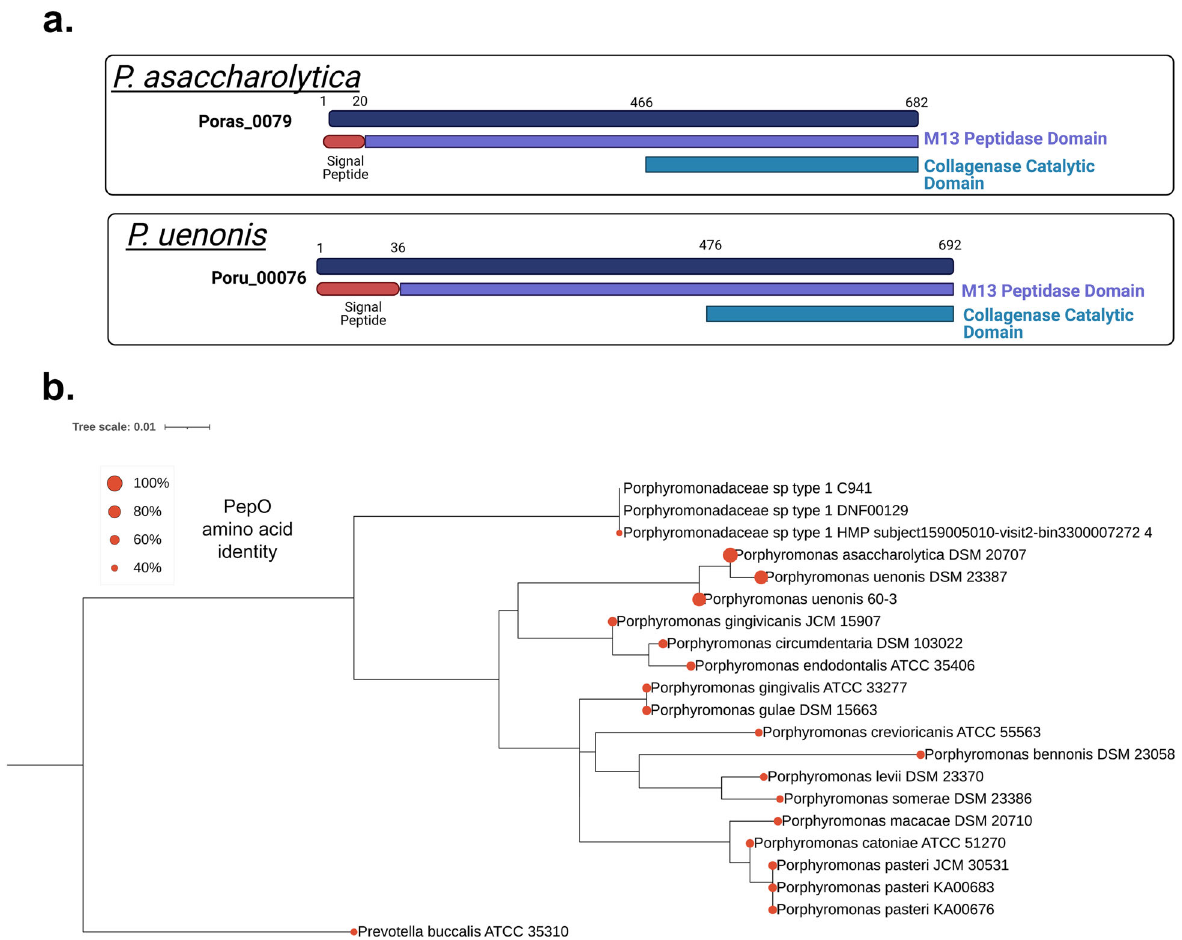
Fig. 6 Secreted PepO metallopeptidases identi fi ed in P. asaccharolytica and P. uenonis . a Domain structure of candidate host-degrading PepO metalloproteases from P. asaccharolytica and P. uenonis . Created with BioRender.com. b 16S rRNA gene phylogeny of Porphyromonas species identi fi ed in the urogenital tract presented as a Maximum Likelihood tree rooted to Prevotella buccalis (same order, different family). Red circles on each leaf indicate the percent amino acid identity of that species ’ PepO ortholog compared to P. asaccharolytica PepO (Poras_0079 = 100%). The taxon previously identi fi ed as uncultivated Porphyromonas species type 1 was found to encompass two cultured, but unsequenced isolates (DNF00129 and C941, >99% 16S rRNA gene identity over 1120 nt). We identi fi ed a metagenome-assembled genome (MAG) in IMG/MER that encoded a 958 bp 16S rRNA gene fragment >99.5% identical to those from the cultured isolates DNF00129 and C941. Since this MAG represents the only genome sequence available for this species, we used it in our PepO queries, identifying an ortholog 42% identical to P. asaccharolytica PepO. As this taxon ’ s PepO ortholog was more distantly related to P. asaccharolytica PepO than the Prevotella buccalis PepO ortholog (47% identical), Porphyromonas species type 1 may represent a novel genus or family; we, therefore, labeled this taxon Porphyromonadaceae sp. type 1. Our phylogenetic analysis, along with inquiries through the Genome Taxonomy Database furthermore indicated that vaginal isolates KA00683 and KA00676 should be designated as belonging to the species P. pasteri , with each containing a PepO ortholog 58 – 59% identical to that from P. asaccharolytica